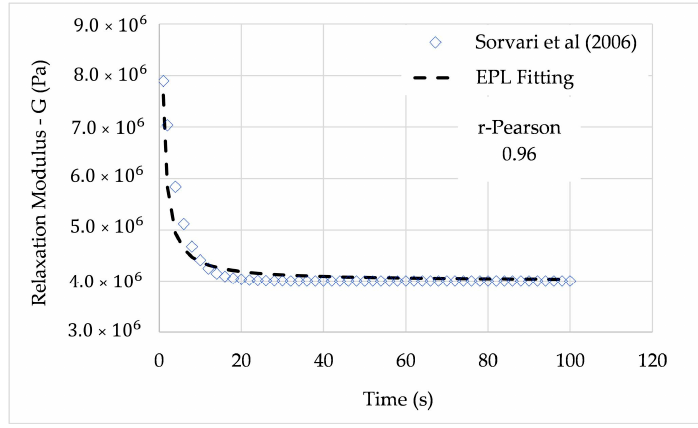
Figure 8. Relaxation modulus from Sorvari et al. (2006) and EPL fitted curve (𝜆 = 4 𝑠) .